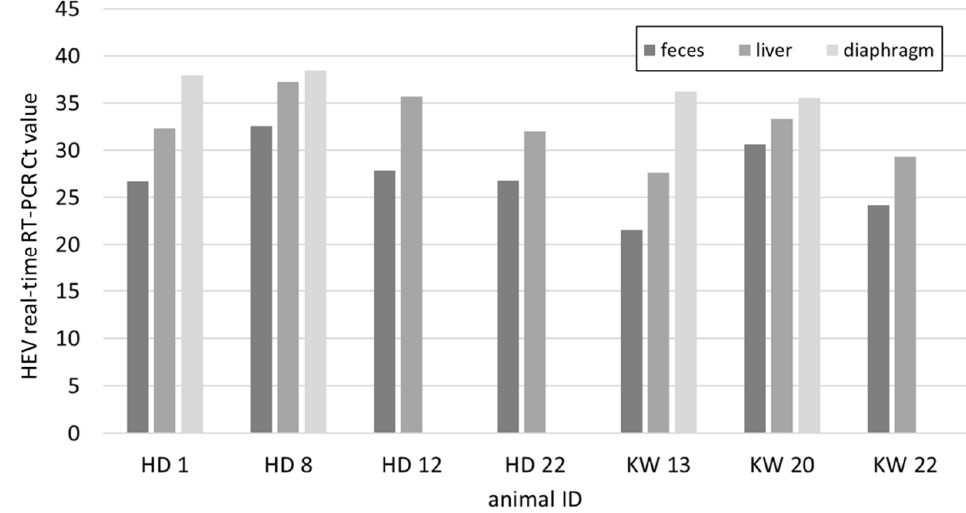
Figure 2. HEV real-time RT-PCR Ct values of faeces, liver, and diaphragm of 7 pigs from CCP that were determined RNA positive in the liver.